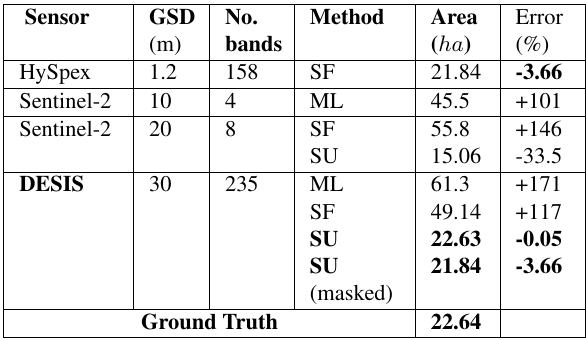
Table 1: Area estimation results for the Oldenburg photovoltaic panels dataset. Area estimation in hectares and relative error in percentage are reported according to sensor, Ground Sampling Distance (GSD), number of spectral bands, and optimal technique used for the kind of data at hand: Maximum Lilkelihood (ML), Spectral Features (SF), or Spectral Unmixing (SU). Spectral Un- mixing (masked) indicates the area estimation after filtering out false alarms by not considering pixels outside of the solar garden.